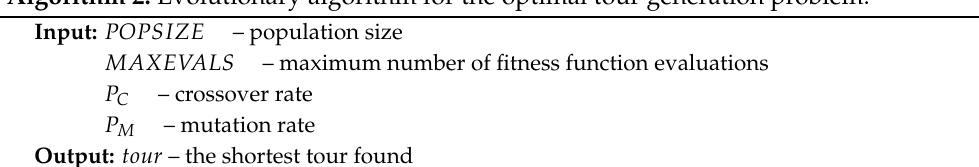
Algorithm 2: Evolutionary algorithm for the optimal tour generation